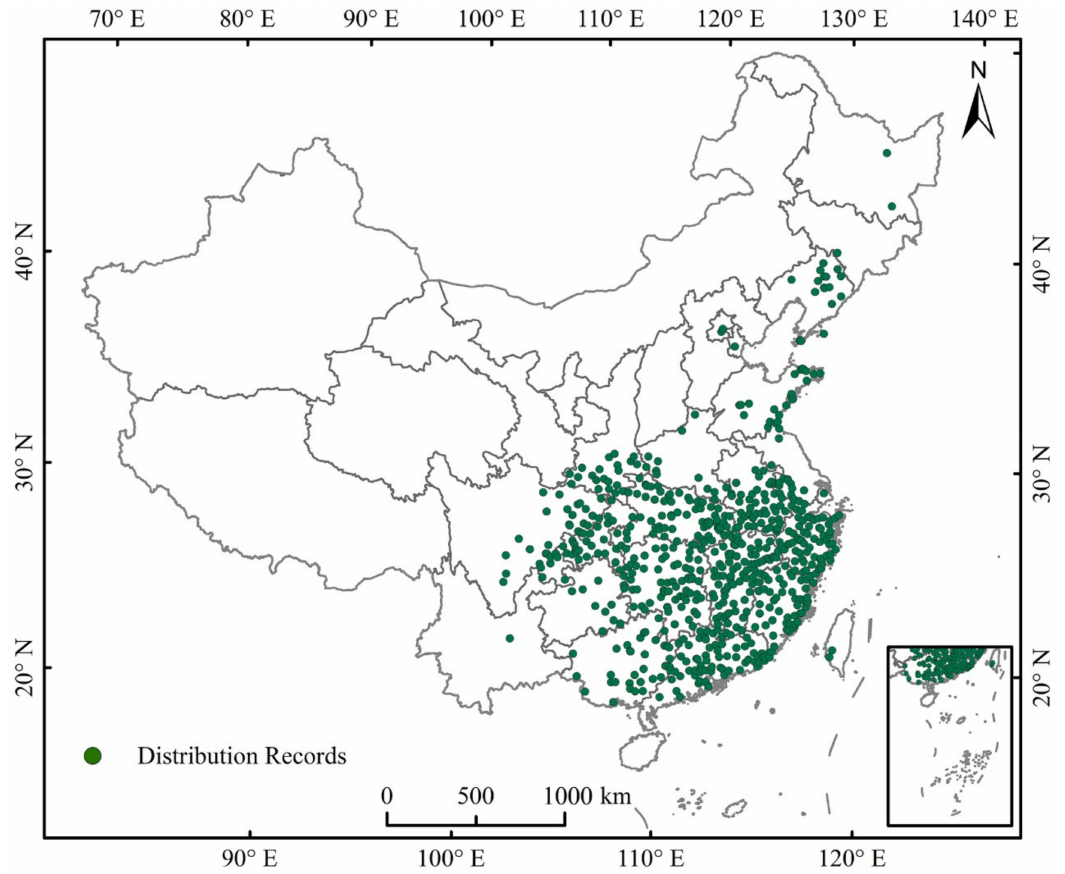
Figure 1. Occurrence records of pine wilt disease in